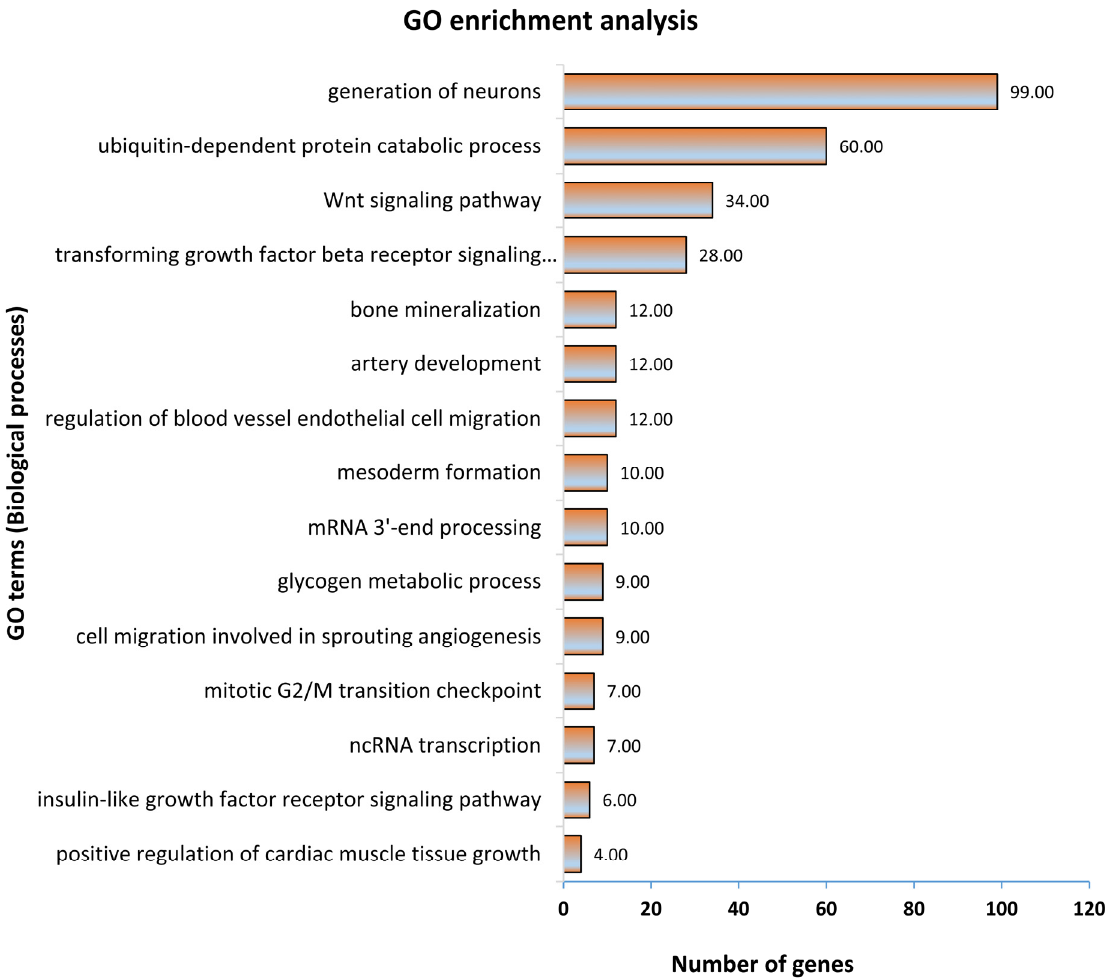
Figure 4. Gene ontology enrichment analysis, with a focus on biological processes, of genes significantly correlated to fetal weight at 63 dpc. Biological processes with a p ≤ 0.05 were considered significantly enriched. A complete list of biological processes significantly enriched by fetal weight-correlated genes is provided in Table S5.